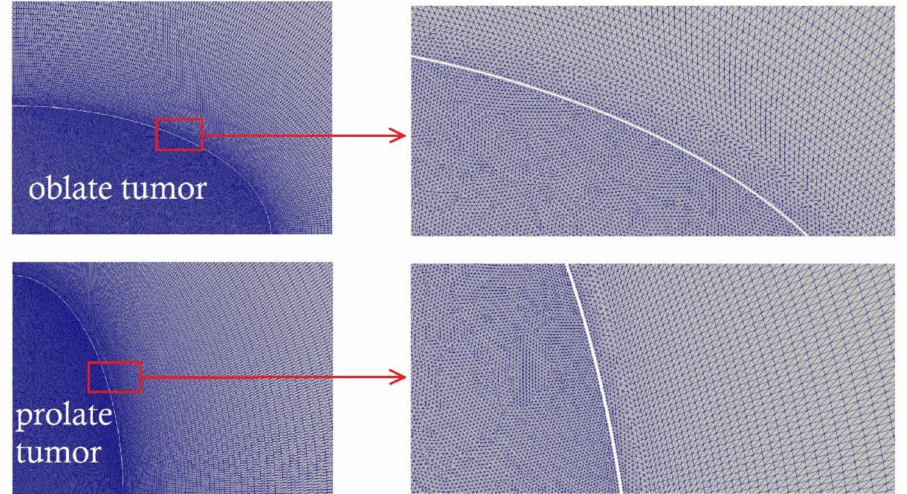
Figure 3. Two representative computational meshes used in the study focused at the tumor region and the close area around it. Magnified views close to the tumor/healthy tissue boundary are also shown. Both meshes correspond to tumors with aspect ratio AR =